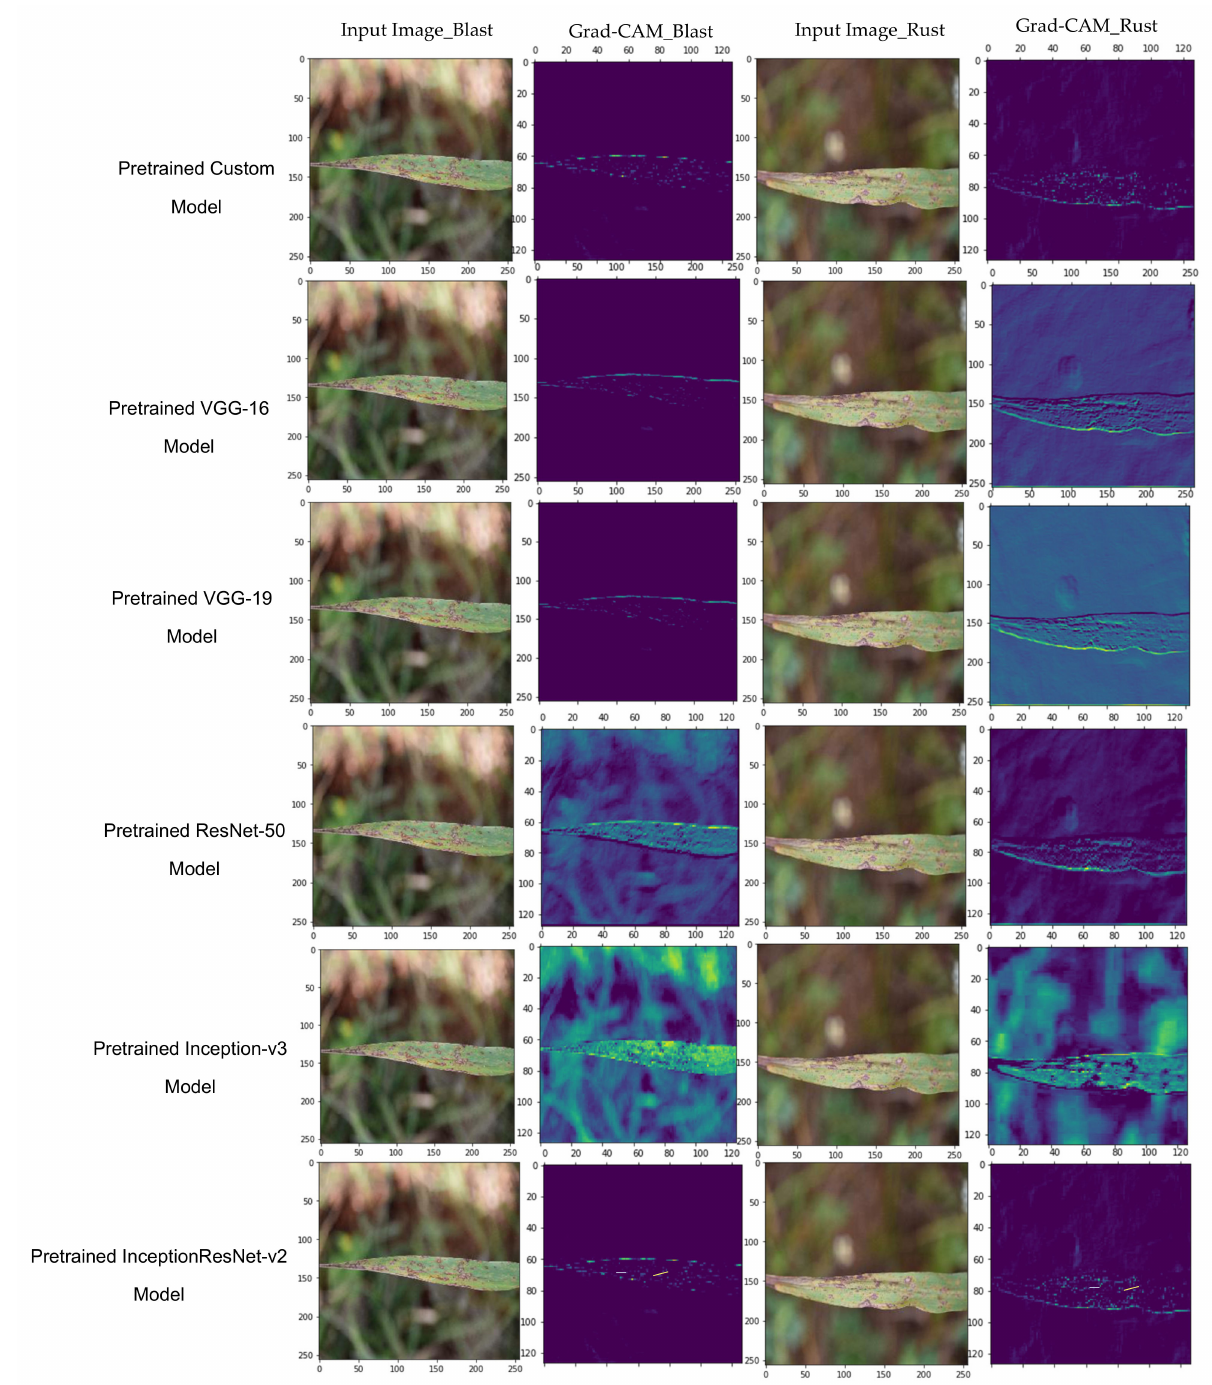
Figure 13. Grad-CAM to visualize the features of pre-trained